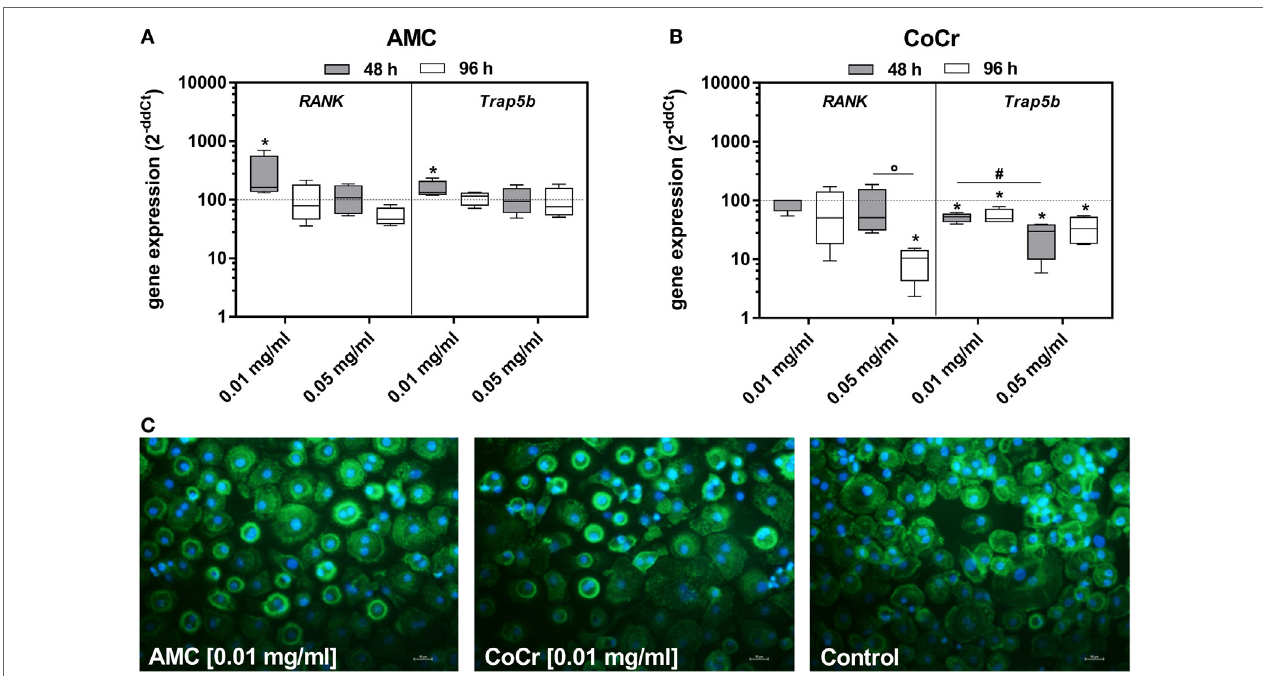
FigUre 4 | Differentiation capacity of human PBMC cultures after exposure to AMC and CoCr particles in different concentrations. Cells were analyzed for gene expression levels of pro-osteoclastic differentiation marker by qRT-PCR (a,B) . Data are shown as box plots ( n = 4). Significances between groups were calculated with the Mann–Whitney U -test (* p < 0.05, treated vs. untreated; # p < 0.05, 0.01 vs. 0.05 mg/ml; ° p < 0.05, 48 vs. 96 h). (c) Representative pictures of actin (green fluorescence) and cell nuclei (blue fluorescence) in PBMC cultures after 48 h of incubation with AMC and CoCr particles. Exposure to particles revealed an enhanced cell number with actin rings as well as formation of membranous ruffled border compared to untreated controls. Bar: 20